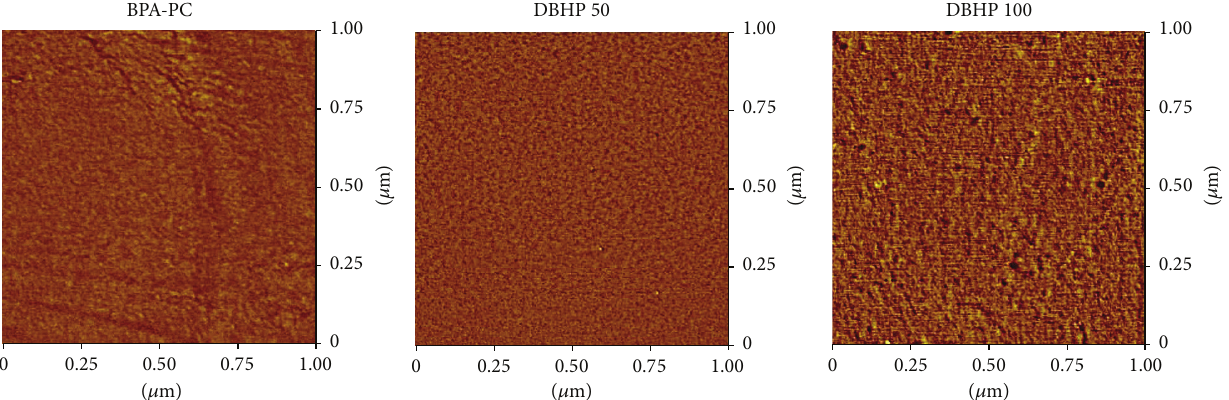
Figure 4: AFM of BPA-PC and DBHP-PCs.